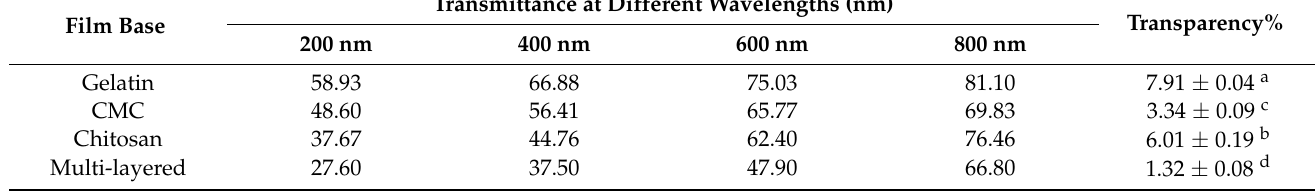
Table 2. Light transmission and transparency of the biopolymer-based monolayer and multi-layer films incorporated with RCE.